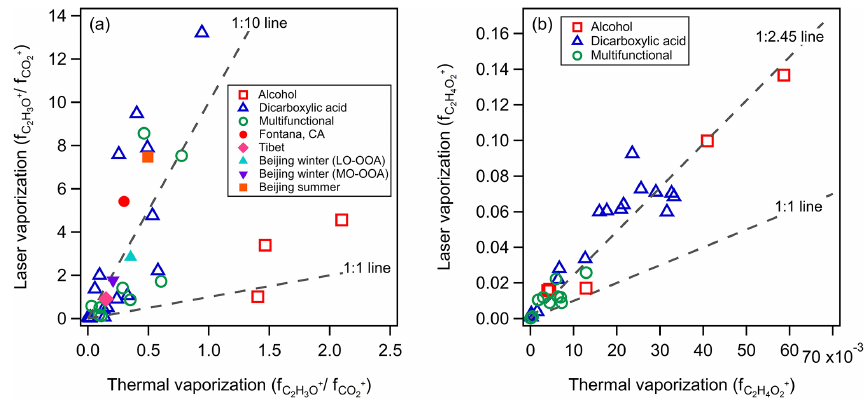
Figure 3. Comparison of (a) f C markers) and collocated field measurement (solid markers) (see Table S1 for the detail of ambient data